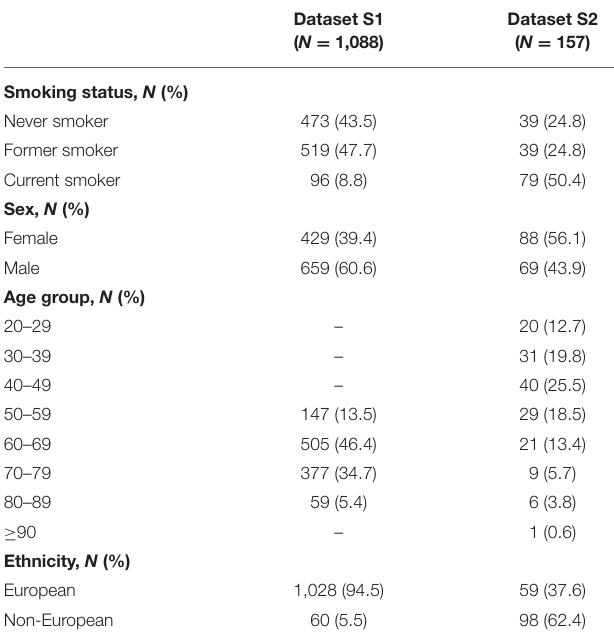
TABLE 1 | Characteristics of the two saliva microbiome datasets used in this